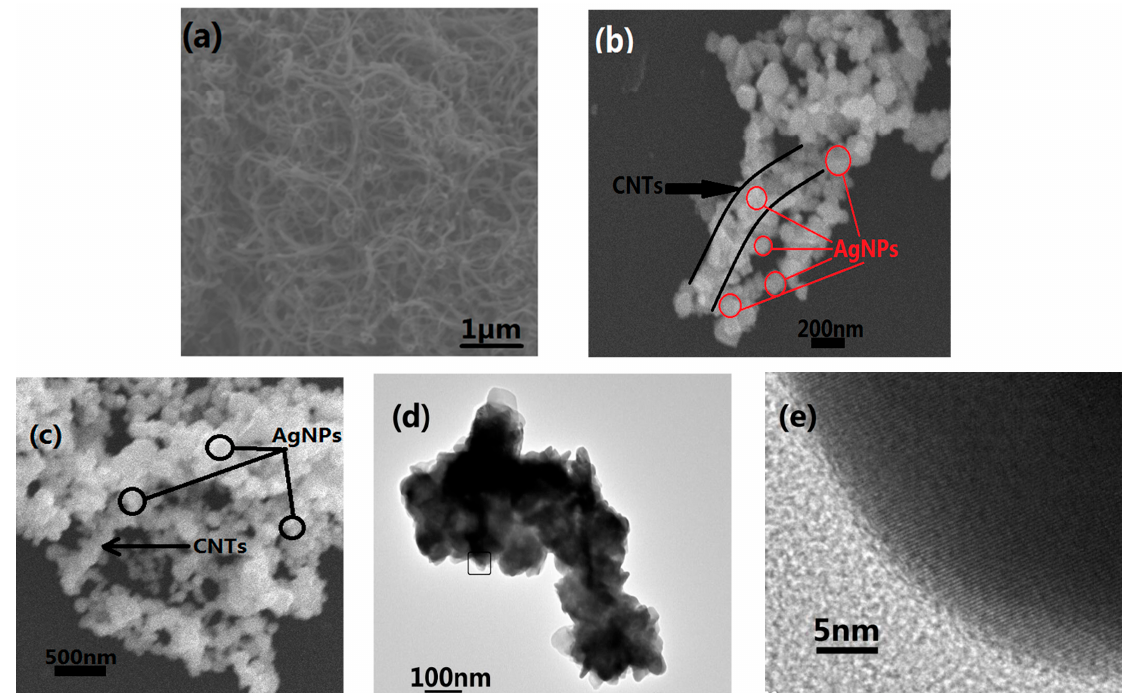
Figure 4. ( a ) SEM image of CNTs; ( b ) SEM image of Ag@CNTs1; ( c ) SEM image of Ag@CNTs2; ( d ) TEM; and ( e ) HRTEM images of Ag@CNTs1.